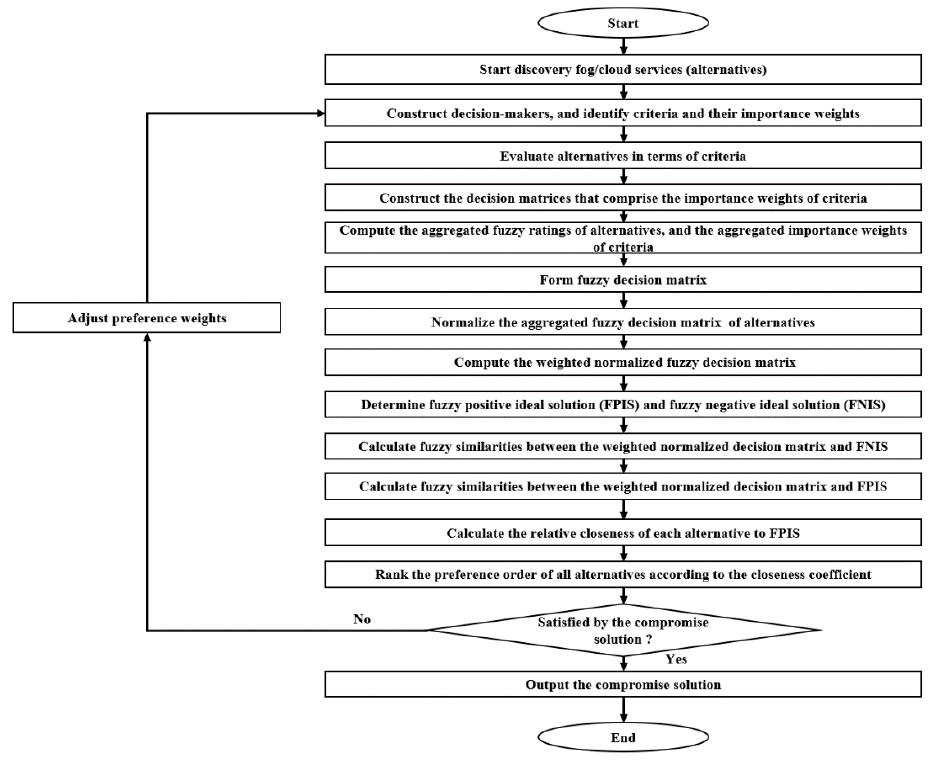
Figure 4. Flowchart of the service selection based on Fuzzy similarity TOPSIS.